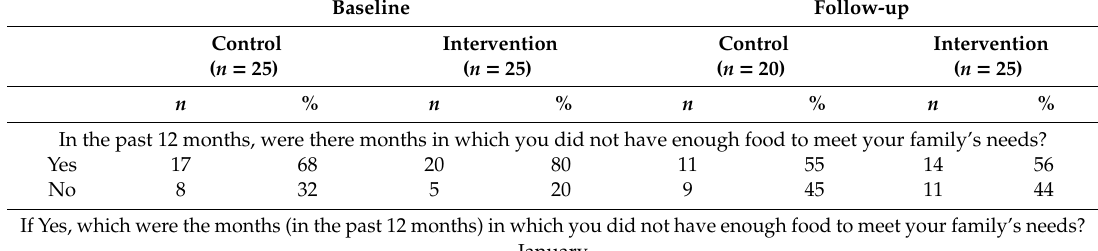
Table 3. Months of Adequate Household Food Provisioning of control and intervention groups at baseline and